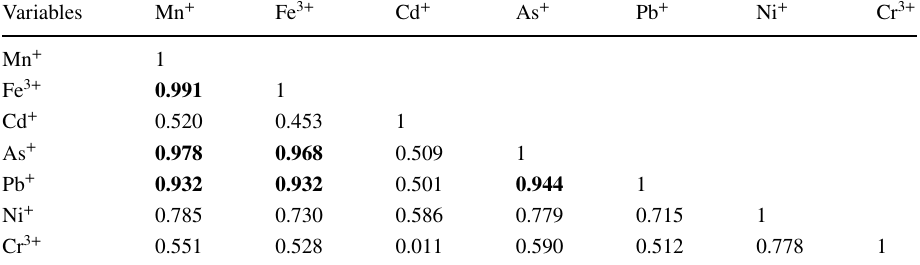
Table 5 Pearson correlation coefficient proximity matrix of the tested water sources